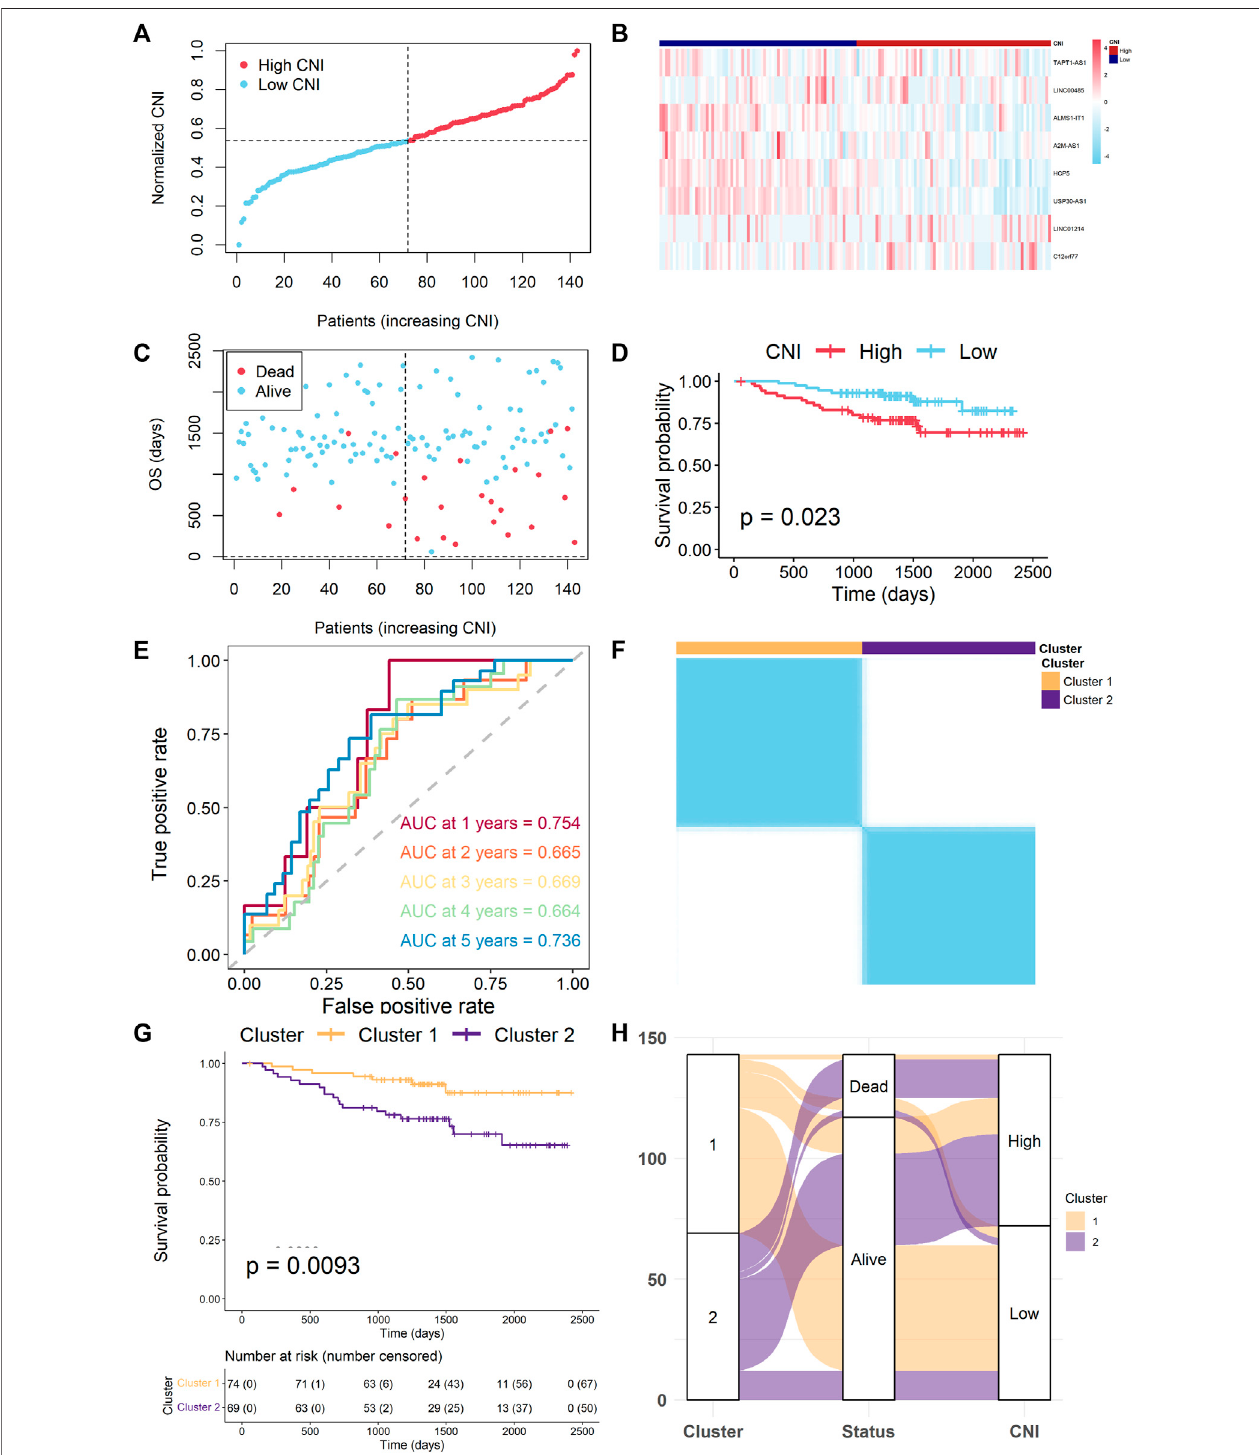
FIGURE 8 | Extra test of the necroptosis-related lncRNAs signature. (A) Distribution of the normalized CNI values in the test cohort. (B) Heat map of expression of modellncRNAsbetweentwoCNIgroupsinthetestcohort. (C) TheCNIvaluesandsurvivalstatusdistributionsinthetestcohort. (D) Kaplan – MeiersurvivalcurvesforOS of TNBC patients with high- and low-CNI groups. (E) Time-independent ROC curves with AUC values to assess the prognostic accuracy of CNI values. (F) Consensus clustering matrix for k = 2. (G) Kaplan – Meier survival curves for OS of TNBC patients with cluster 1 and cluster 2. (H) The alluvial diagram fully demonstrated the correlation of prognosis between clusters and CNI